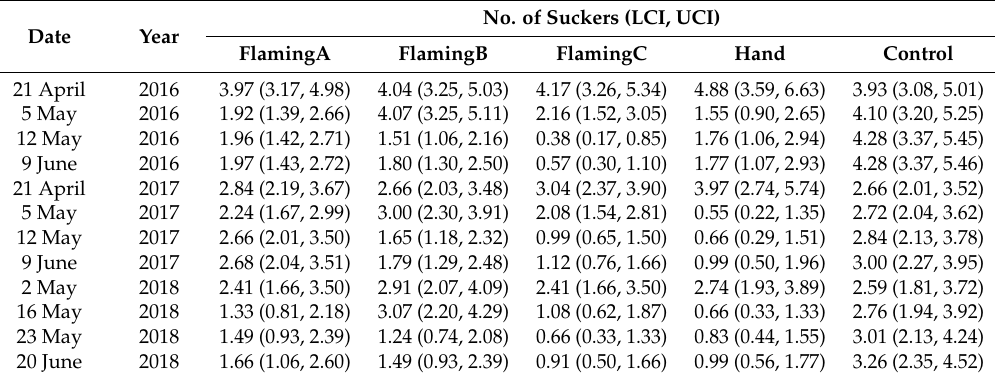
Table 3. Inverse transformed values (from the log scale) and lower and upper confidence intervals (LCI, UCI) of the least squares means of the number of suckers per plant as affected by different type of suckering methods and data collection date in the three-year